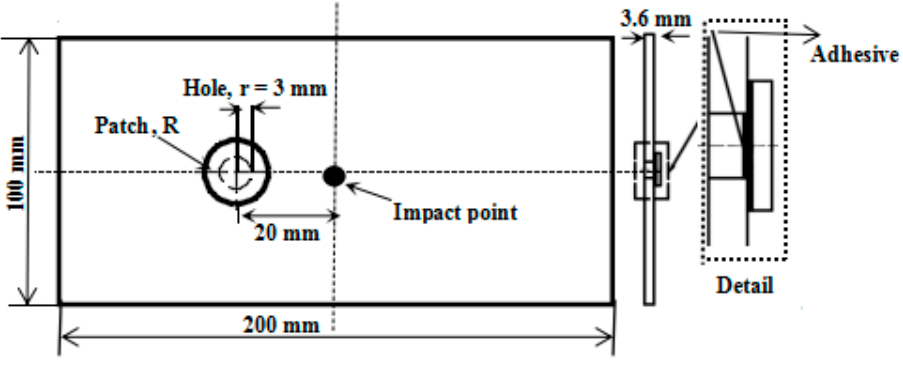
Figure 2. Geometric configuration of the repaired plates.